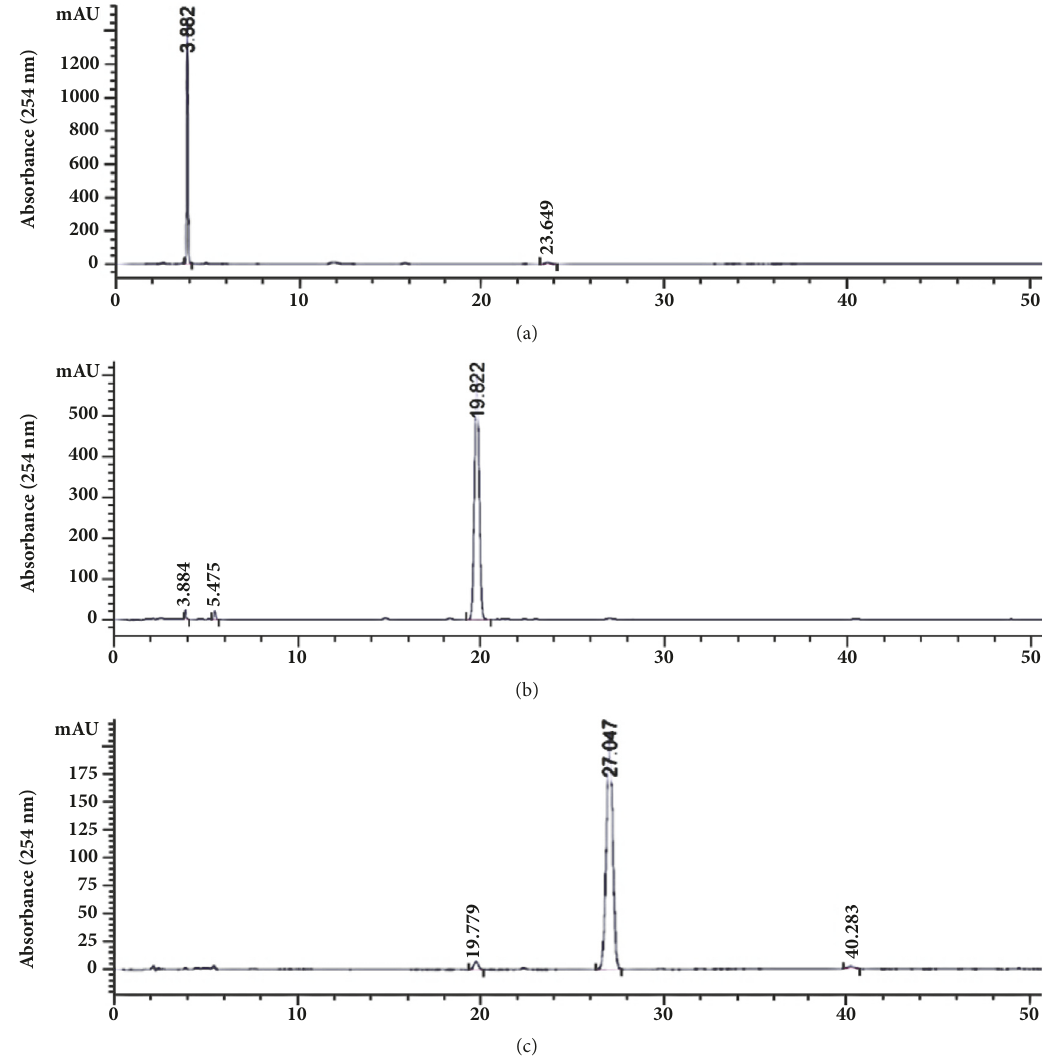
Figure 5: HPLC chromatograms of CPC peak fractions I (a), II (b), and III (c) (for chromatography conditions, see Section